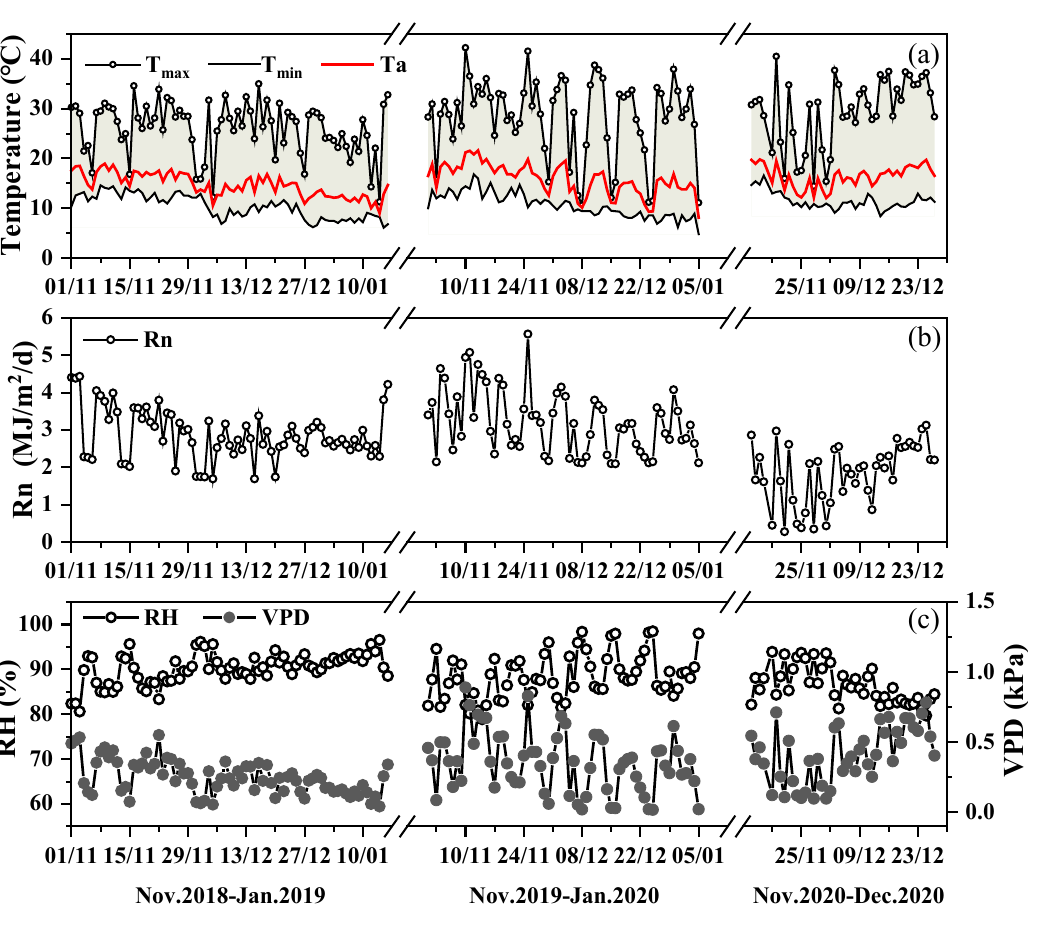
Figure 2. Variations of daily mean micrometeorological elements in the sunken solar greenhouse during the 2018–2020 winter periods. ( a ) daily maximum (T max ), minimum (T min ), and mean air temperature (T a ), ( b ) net radiation (R n ), and ( c ) relative humidity (RH) and vapor pressure deficit (VPD). During the Tr modeling period, the LAI varied between 1.55 and 3.27, and the plant